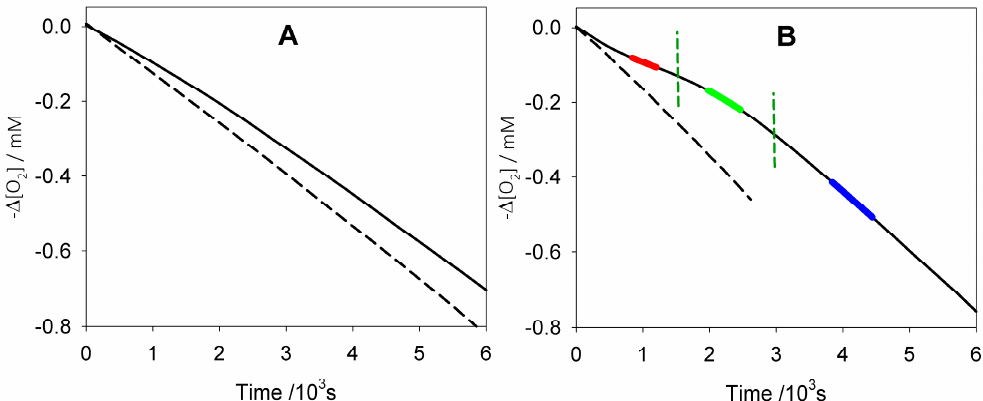
Figure 1. Oxygen consumption during the autoxidation of tetrahydrofuran (THF, 3.1 M) initiated by 2,2 ′‐ azobis(2 ‐ methylpropion ‐ amidine)dihydrochloride (AAPH, 0.025 M) at 30 °C without inhibitors (dash) or in the presence of quercetin (solid). ( A ) In phosphate buffer 0.1 M pH = 2.1 with quercetin 2.5 × 10 − 5 M; ( B ) In phosphate buffer 0.1 M pH = 7.4 with quercetin 5.0 × 10 − 6 M, vertical lines indicate the time lapse corresponding to the trapping of n = 2 peroxyl